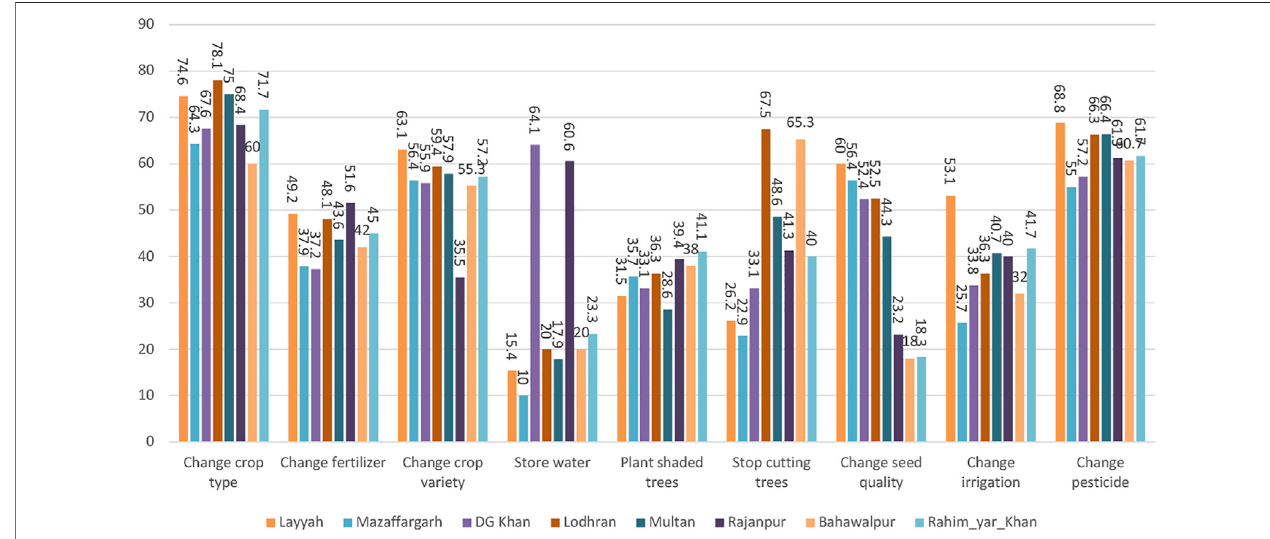
FIGURE 4 | Adaption strategies/measures (%) by farmers in South Punjab, Pakistan.